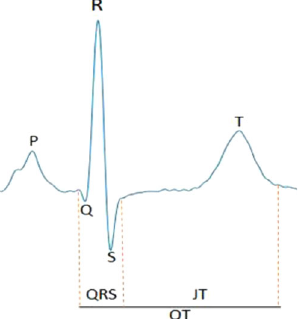
Fig. 1 | Annotation of an example ECG signal. QRS duration and the JT interval approximate the time periods for ventricular depolarization and repolarization